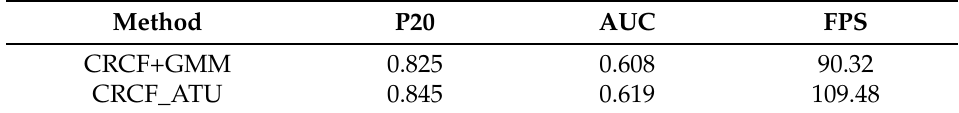
Table 1. Comparative results of model update